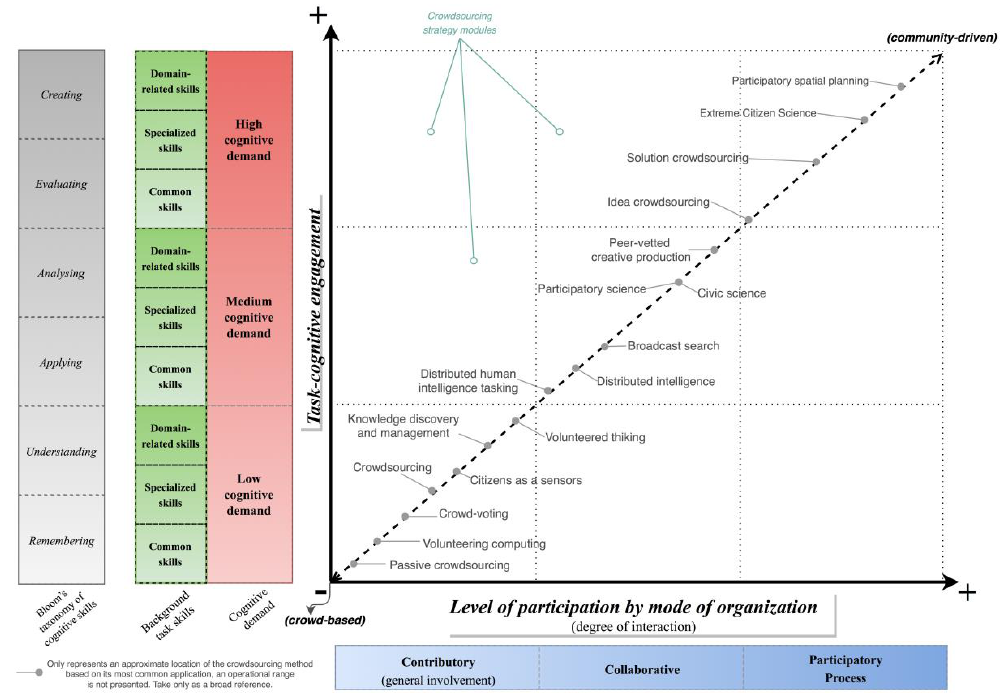
Figure 4. Design Criteria of the Central Crowdsourced Processing Unit and Strategy of a VGI Project.